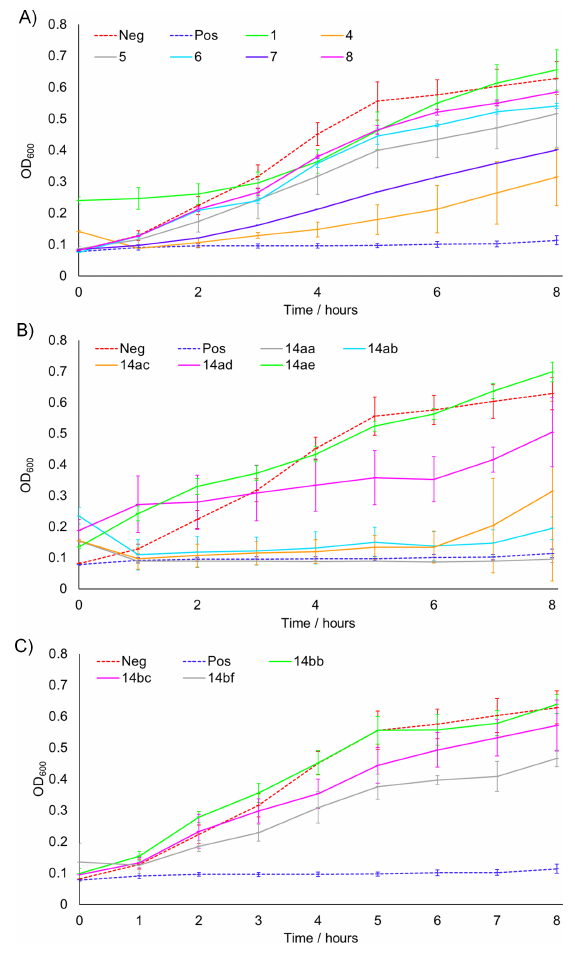
Figure 3: Growth of S. aureus 25923 with time in the presence of 200 μ M of each compound. A) Natural product series. B) Saturated an- alogue series. C) Truncated analogue series. Neg = negative control (DMSO blank), Pos = positive control (gentamicin). Experiments